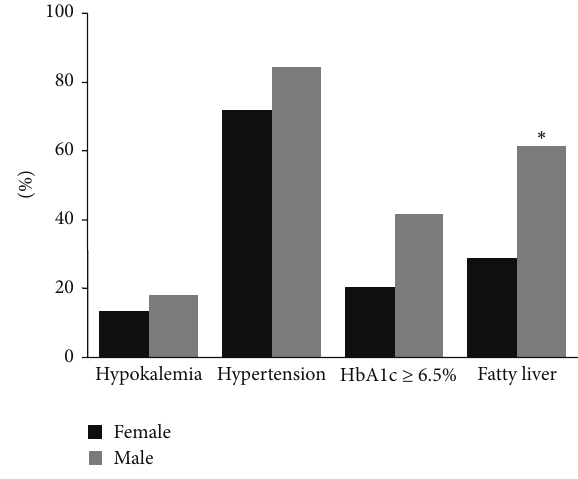
Figure 1: Diurnal plasma cortisol and ACTH curves in male and female patients with CD ( ∗ 𝑃 < 0.05 , Mann-Whitney 𝑈 test).